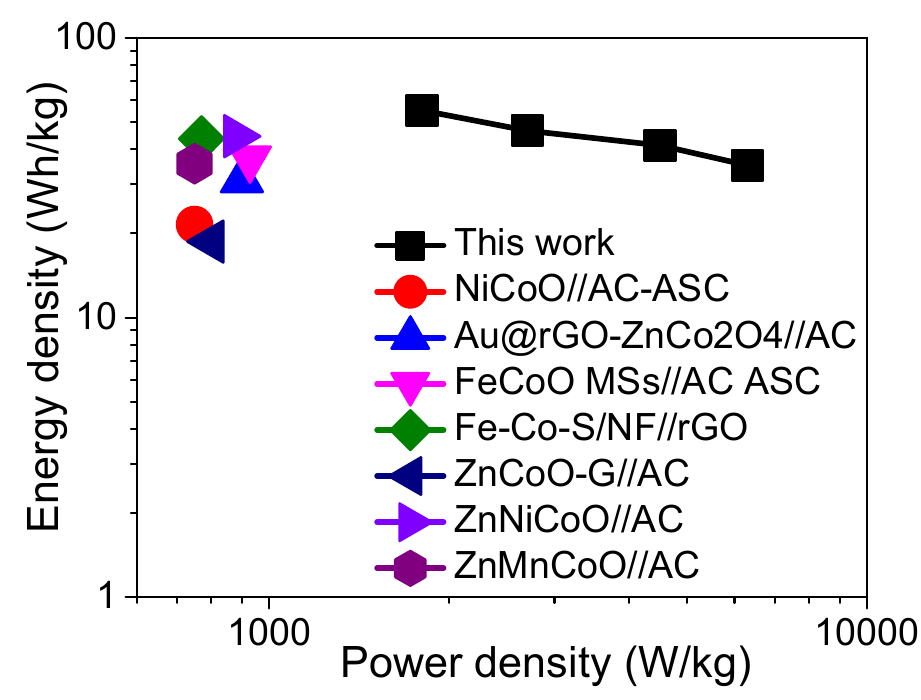
Figure 8. Ragone plot of ZFO-NF@CC||AC@CC-HSC and comparison with recently reported work.